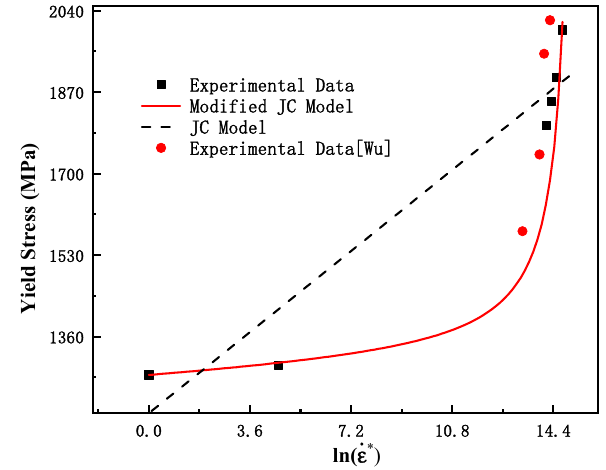
Figure 5. Variation of yield stresses with logarithmic strain rates.